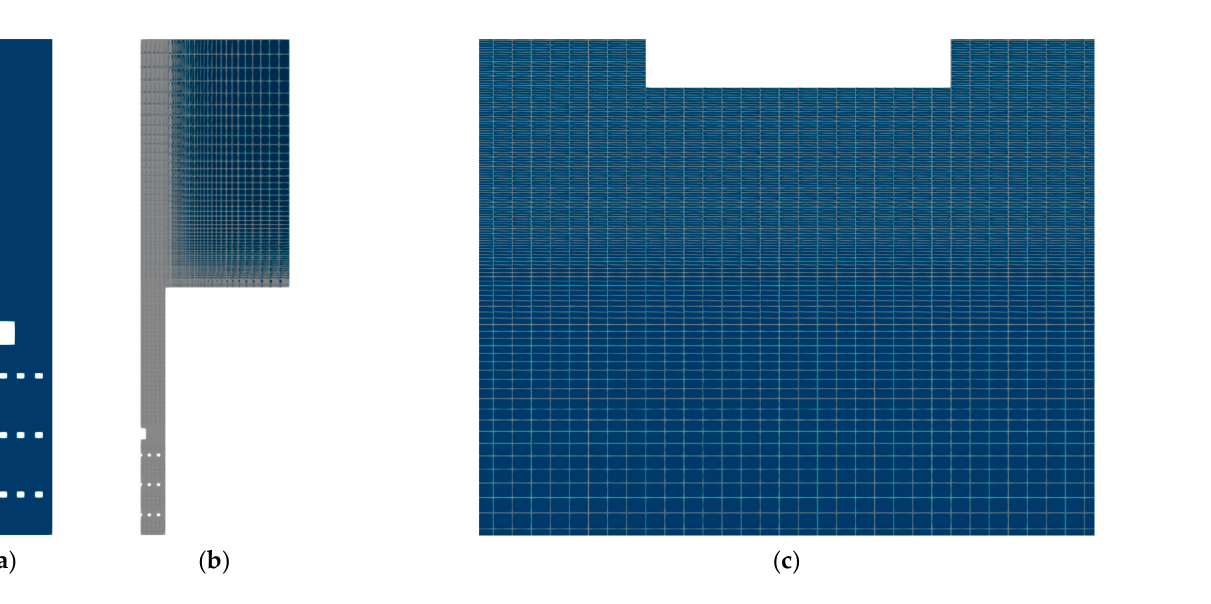
Figure 12. Vented chamber and computational grid: ( a ) chamber scheme, ( b ) overall mesh view and ( c ) computational mesh details below the upper obstacle.